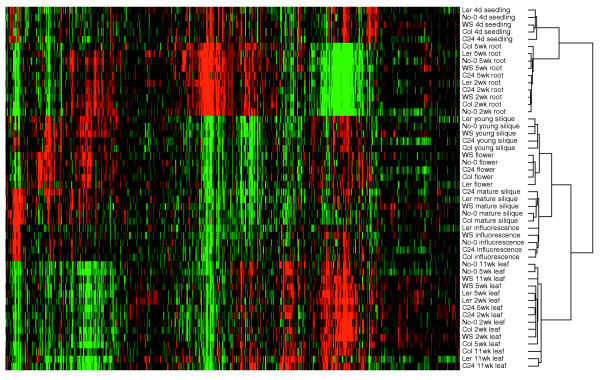
Relationships among the five Arabidopsis accessions based on their expression patterns in different organs at various developmental stages. The normalized expression values, obtained by dividing the mRNA expression indices of each organ of one accession by the intensity indices in genomic DNA hybridization for that particular accession, were log2-transformed and subjected to cluster analysis. The yellow vertical lines separate the whole cluster into three subclusters, the root cluster, the vegetative leaf cluster, and the reproductive organ cluster.